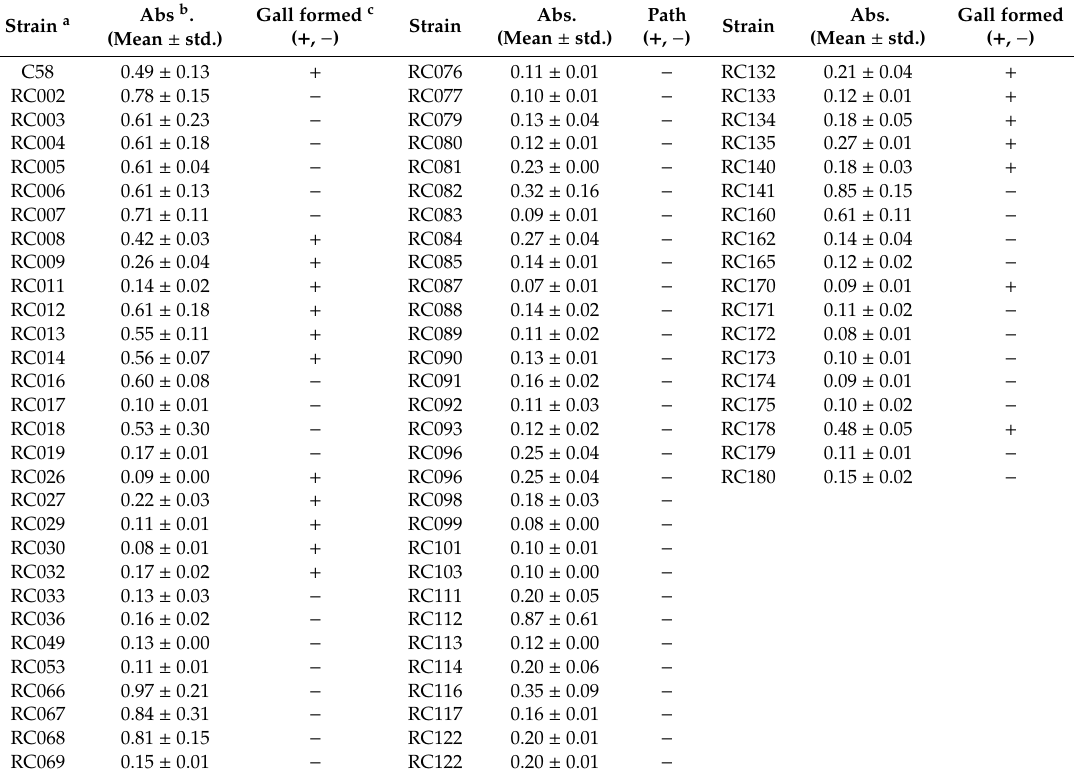
Table 3. Biofilm formation and pathogenicity of A. tumefaciens isolate from rose crown gall. Strain